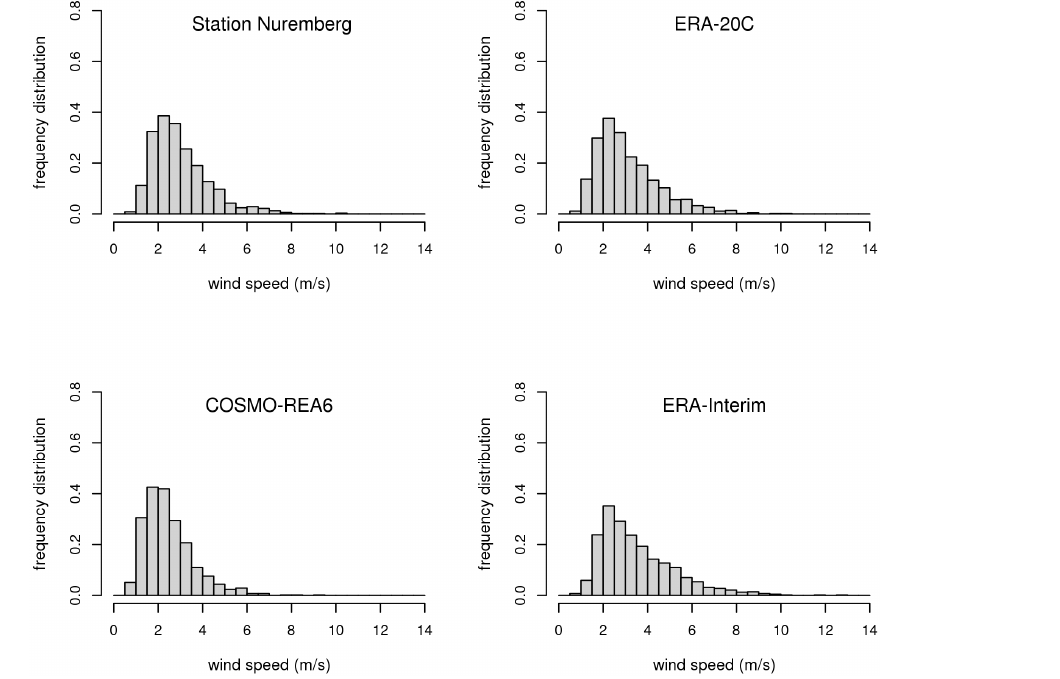
Figure 4. Frequency distribution of daily mean wind speeds in the period 2007 to 2010 for the station Nuremberg (top left) and matching grid cells of ERA-20C (top right), COSMO-REA6 (bottom left), and ERA-Interim wind fields (bottom right).